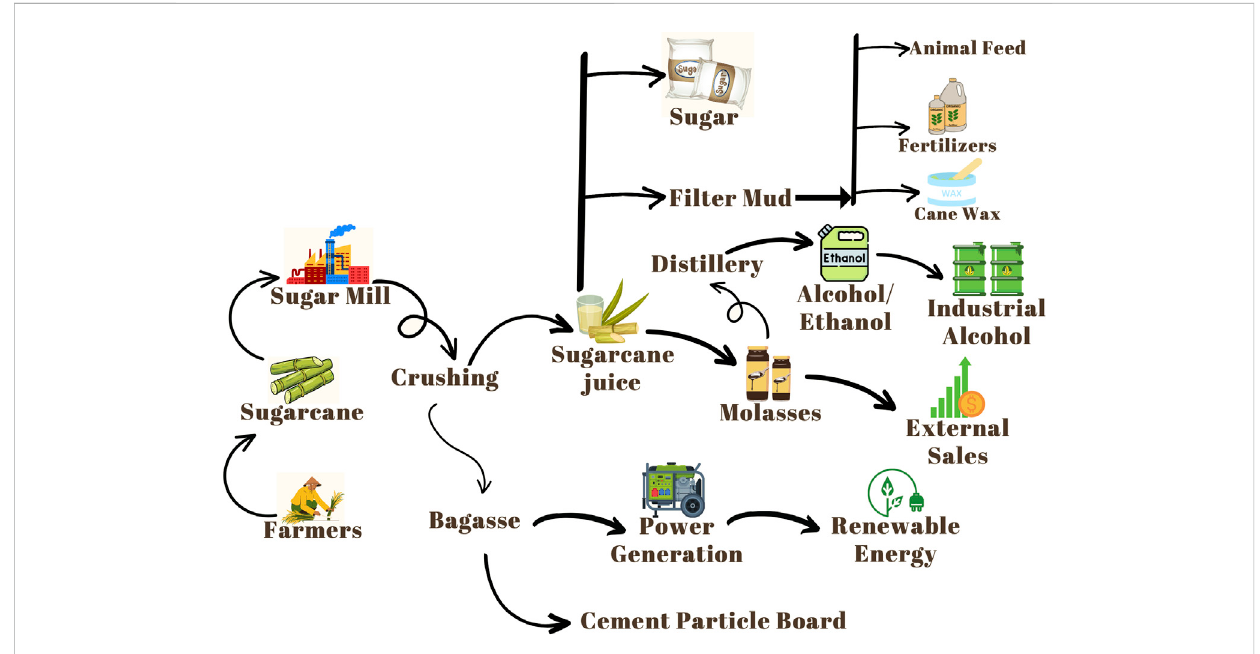
FIGURE 1 General schematic by-product of Sugar